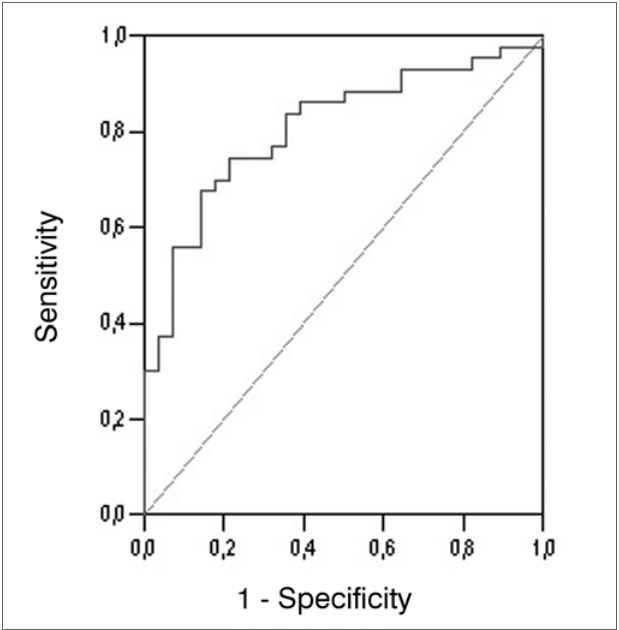
Figure 4. Graphic representation (ROC curve) of the plotting of nume- rous sensitivity and specificity points of the SP/AP ratio considering GC and